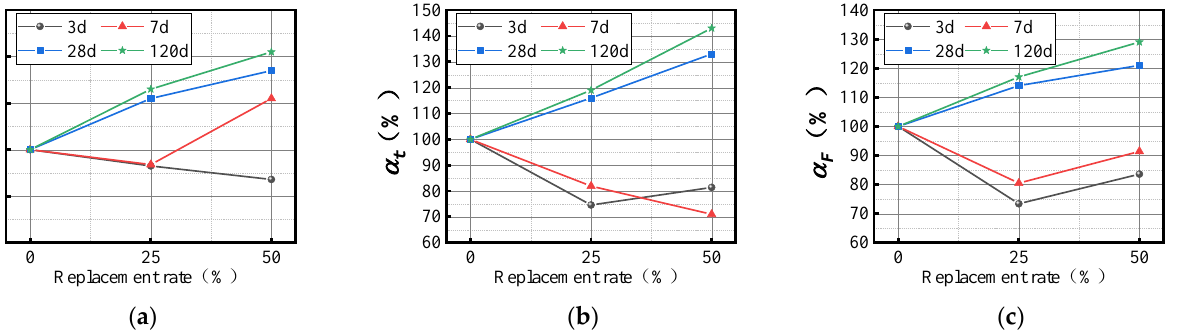
Figure 8. Strength activity index a of samples: ( a ) the compressive strength activity index а c ; ( b ) the tensile strength activity index а t ; ( c ) the cracking resistance activity index а F.